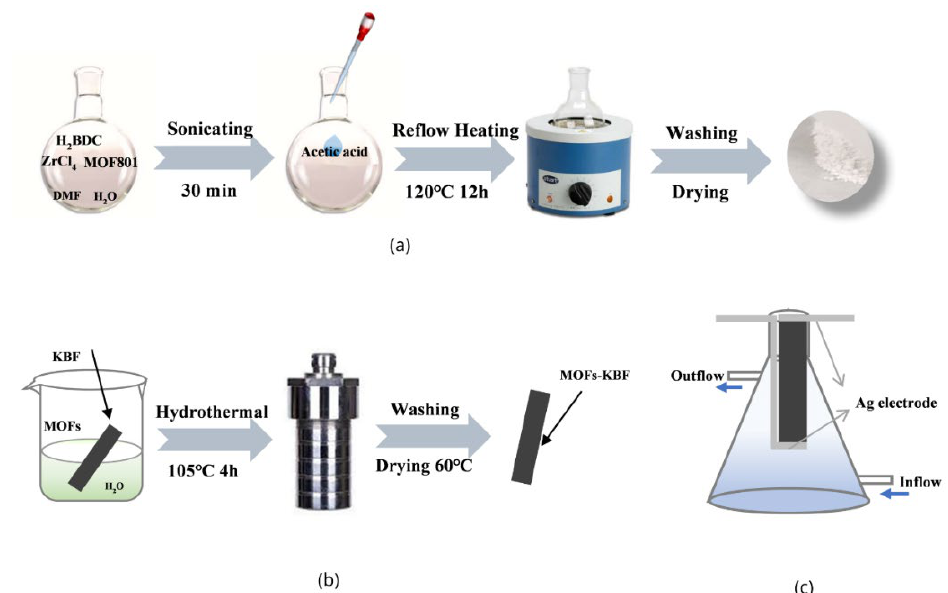
Figure 1. ( a ) Synthesis process diagram of UIO66/MOF801. ( b ) Process of MOFs-modified KBF. ( c ) Schematic diagram of the power generation device.